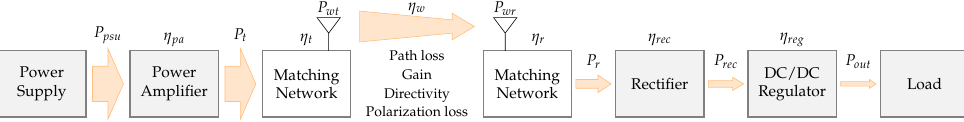
Figure 18. Overview of the system concept, transmission, and efficiency model for RF power transfer.